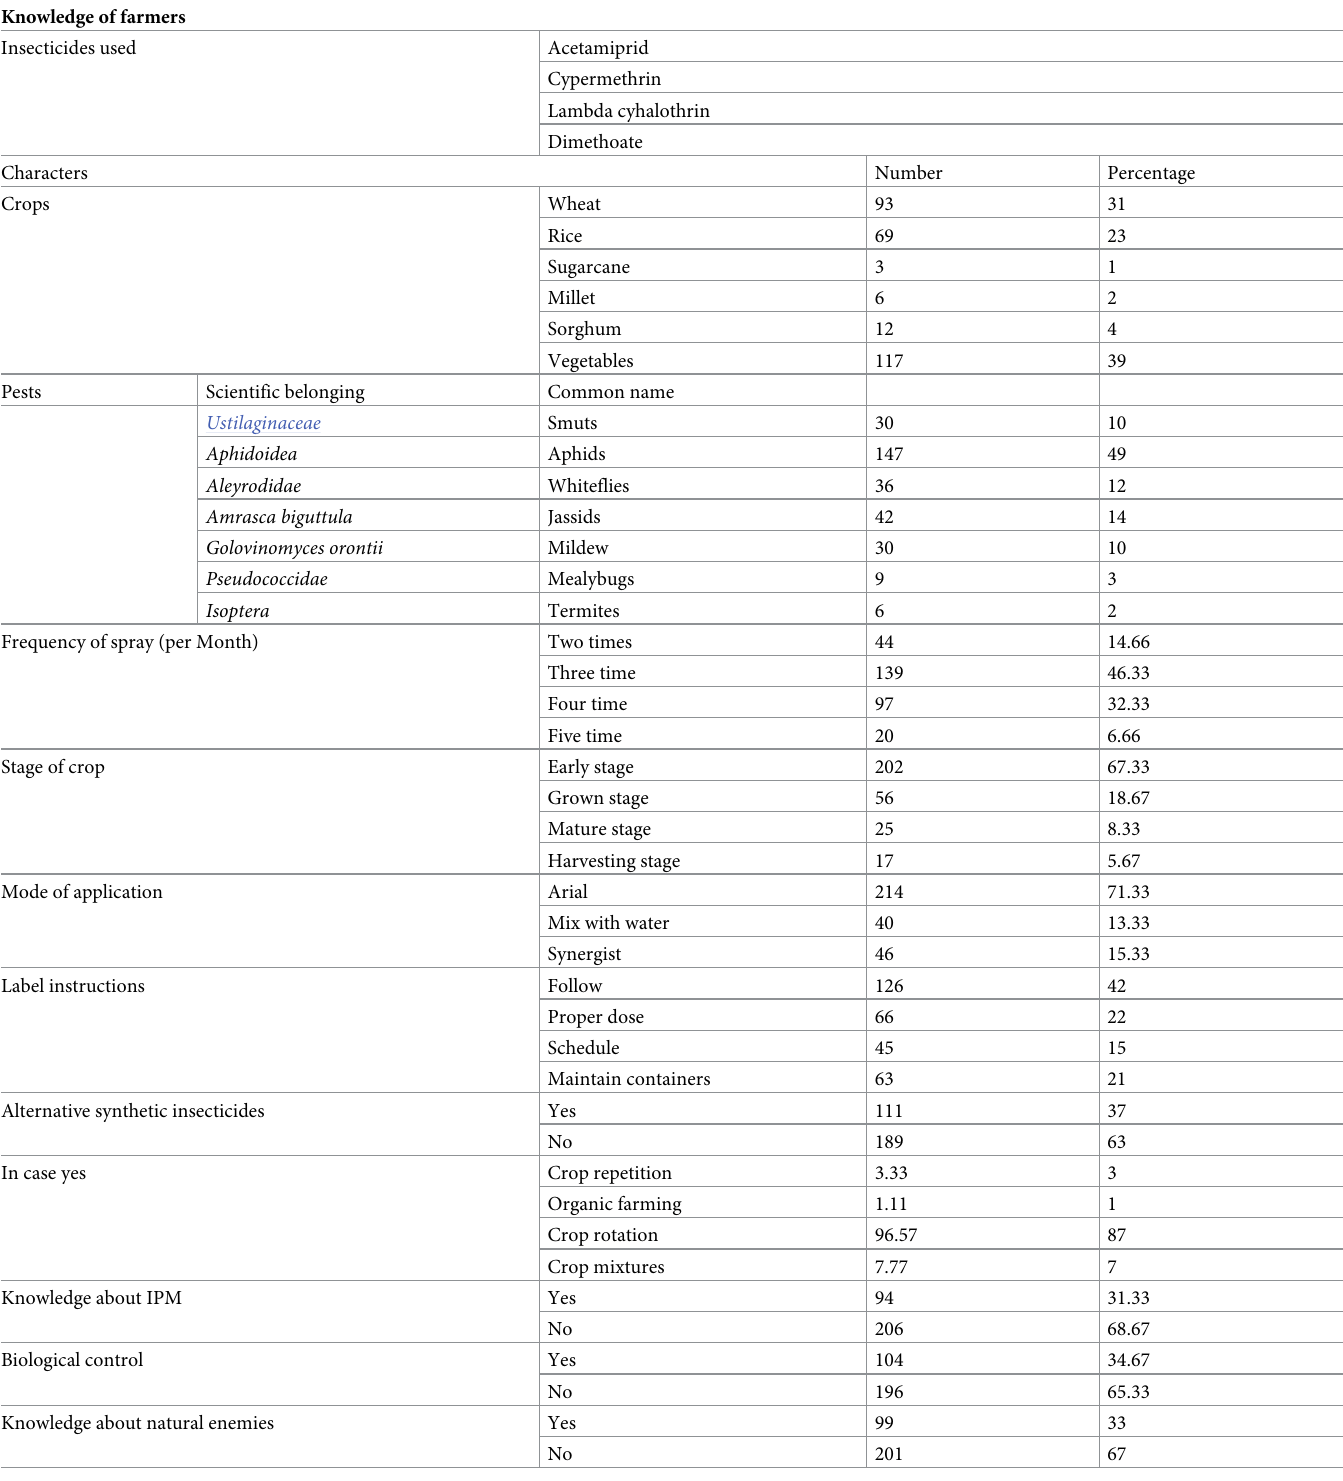
Table 2. Knowledge of respondents in three localities of province Punjab Pakistan (n =